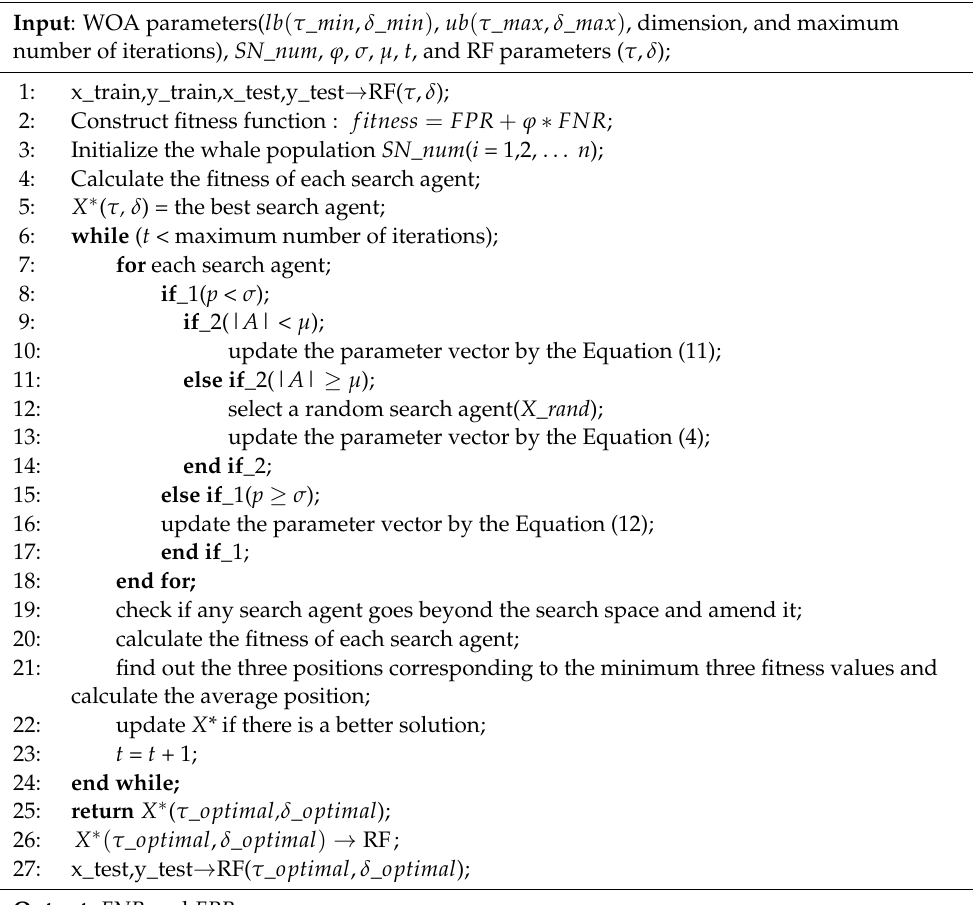
Algorithm 2: Implementation of IWOA-RF fault detection